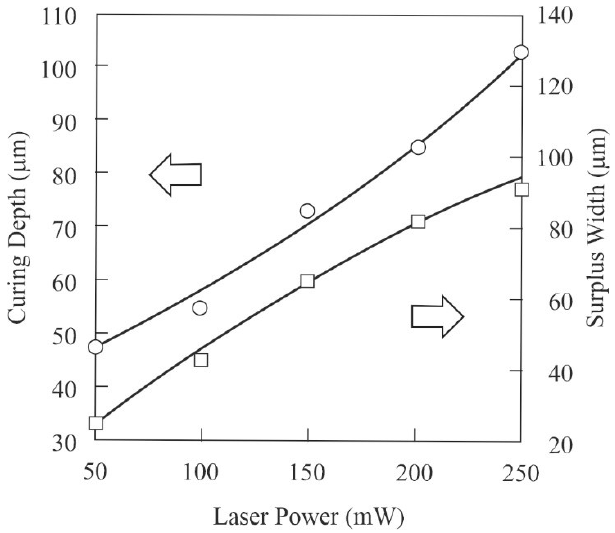
Figure 9. The numerical variations of the curing depths and dimensional tolerances according to the irradiation powers in laser drawing. Correlation graphs were obtained from the systematic measurements using the resin pastes with the yttria-stabilized zirconia (YSZ) particles.